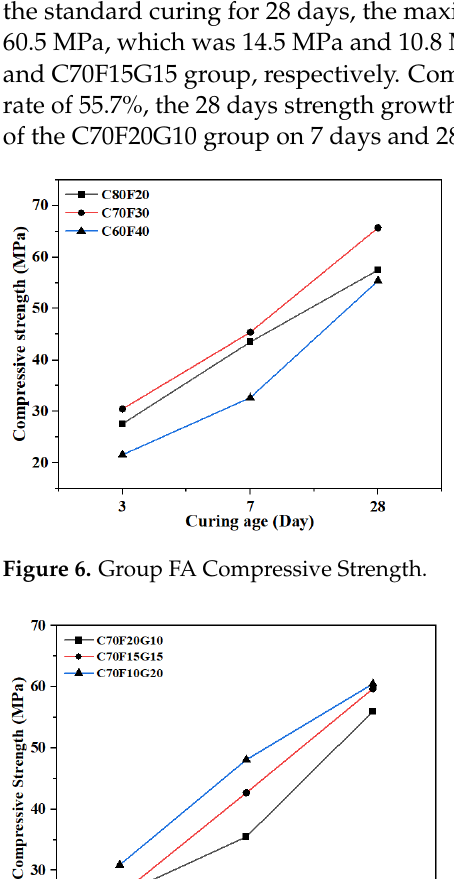
Figure 6. Group FA Compressive Strength.